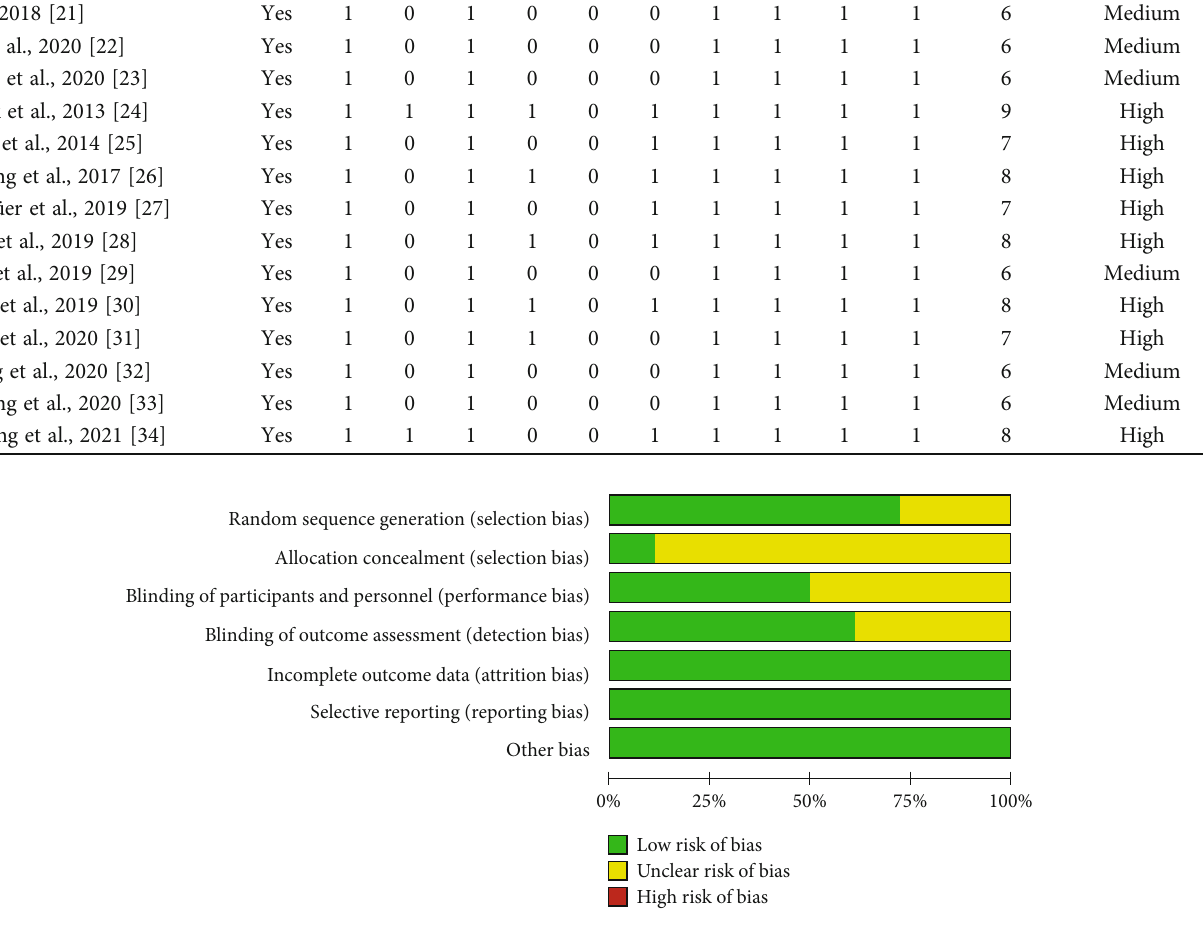
Figure 2: Bias risk assessment of included